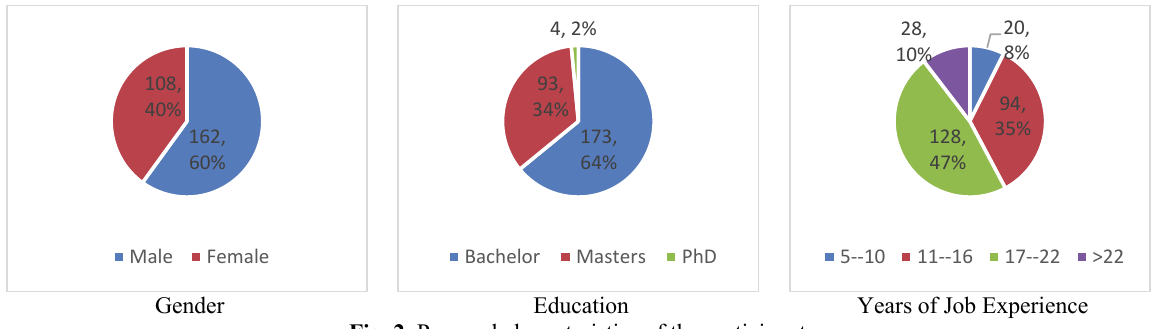
Fig. 2. Personal characteristics of the